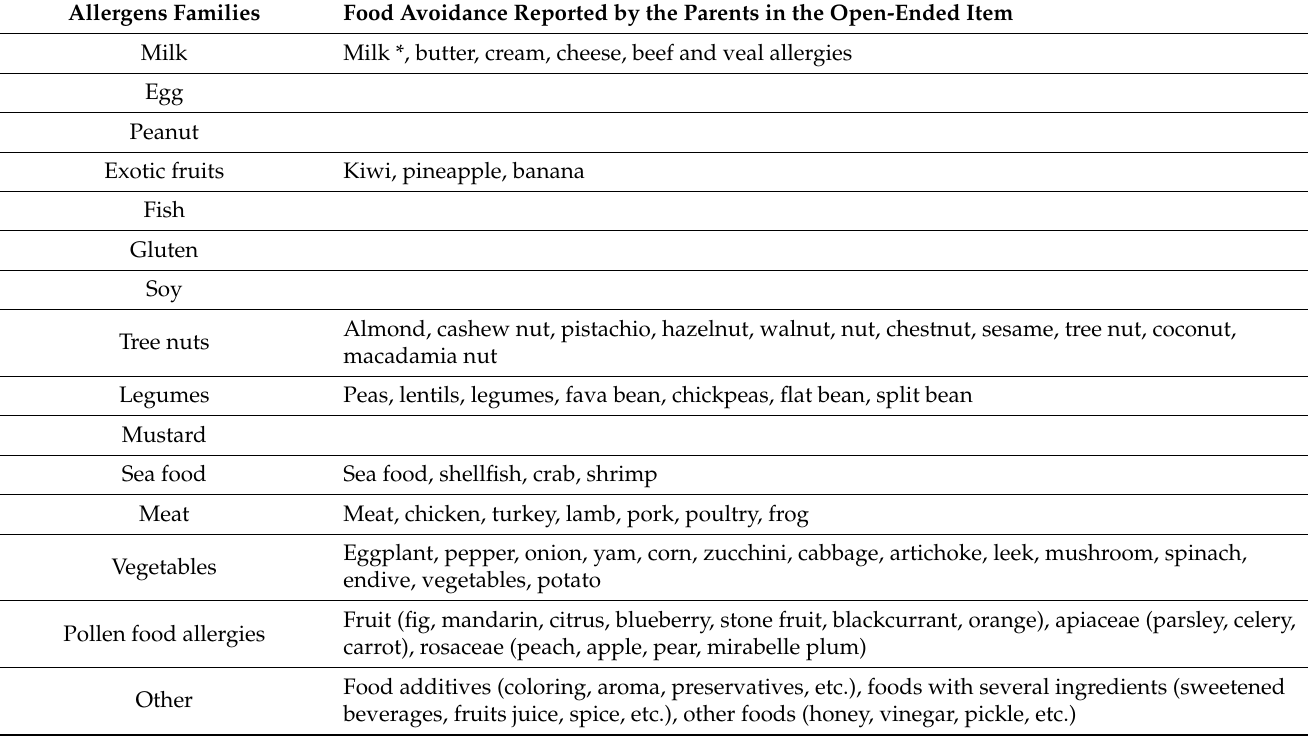
Table 1. Allergen